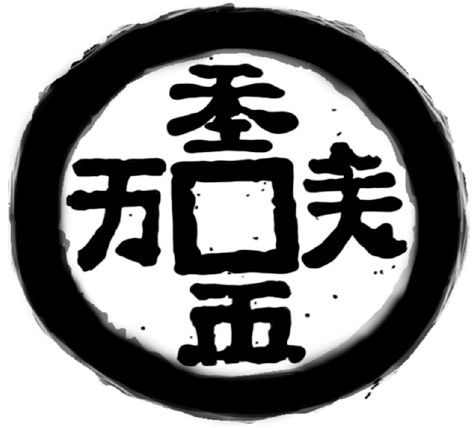
Figure 40. A Khitan coin inscribed with four characters. The Liao Dynasty. Sketched by author. Picture source: Wei (1984), p.